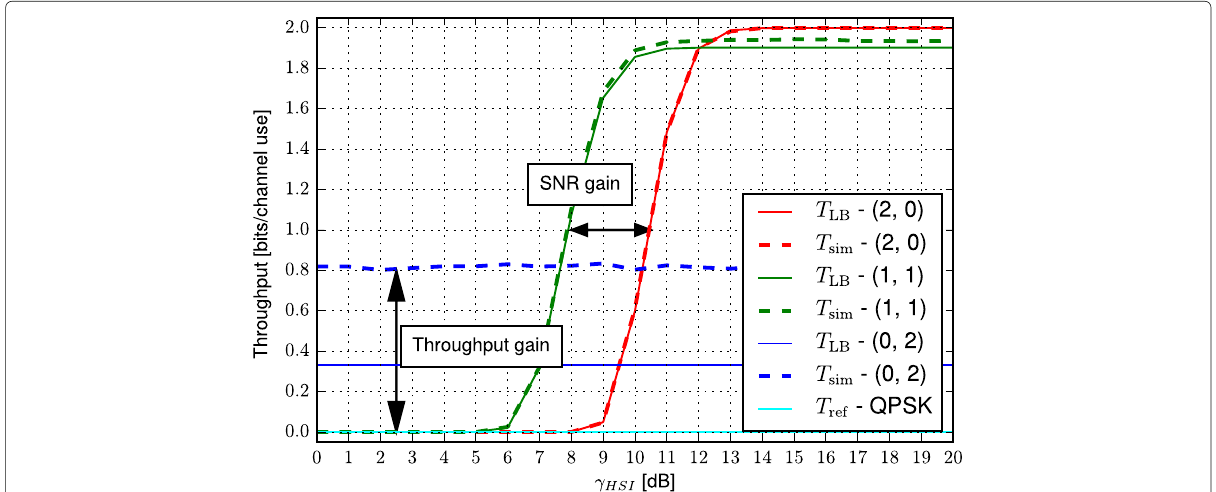
Fig. 7 Comparison of throughput as a function of γ HSI for γ MAC = 17dB, γ BC = 17dB and given ( N b , N s